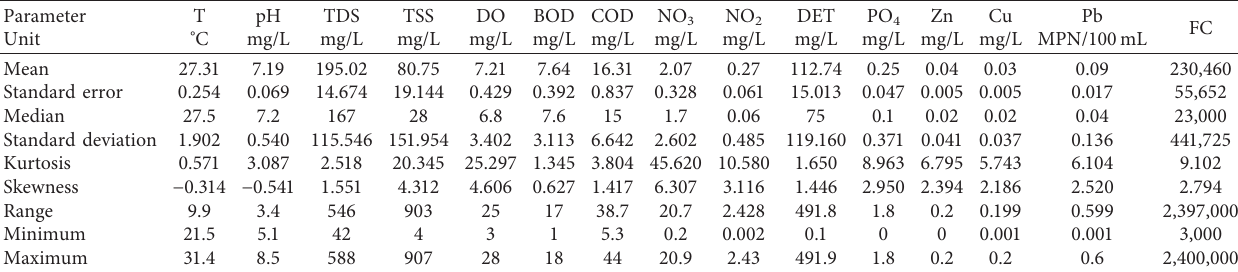
Table 1: Summary of water quality in Code River from in three monitoring stations 2011–2017. Parameter